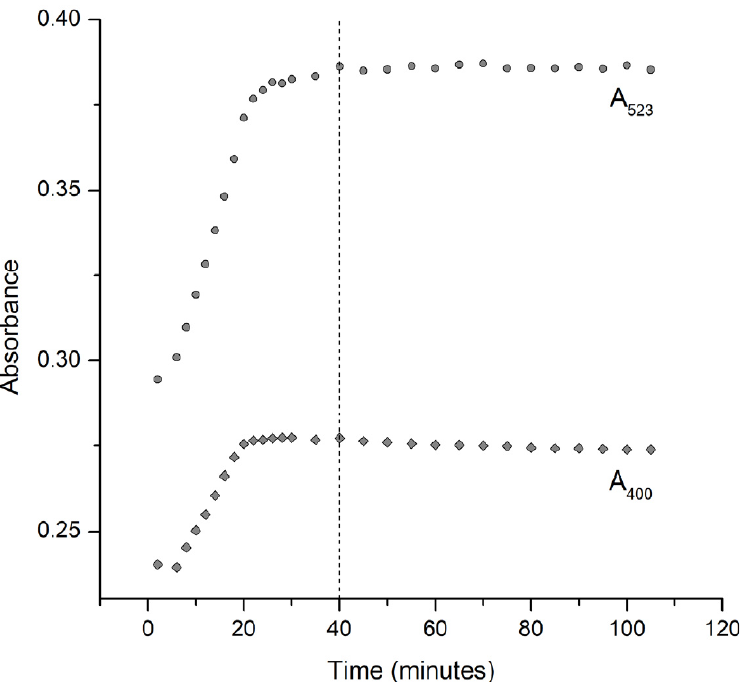
Figure 4. The kinetic curves for two positions in UV–VIS spectra: absorbance at 400 nm (Au 0 ) and at 523 nm (spheres ca. 10 nm in diameter). The dashed line indicates the growth process completion 40 min after the reaction